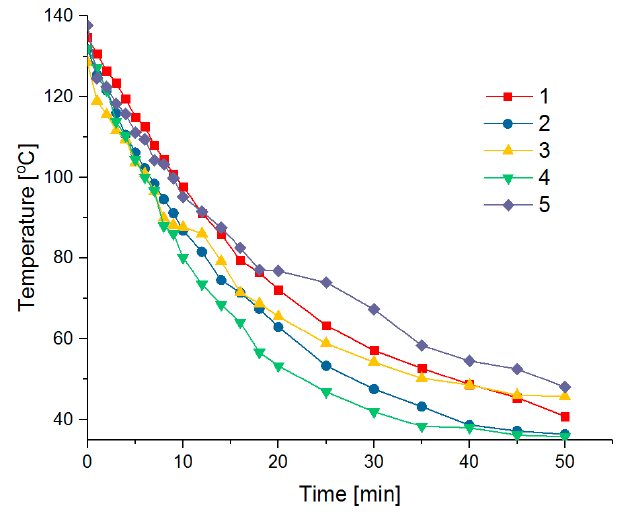
Figure 5. Combined temperature distribution diagram on the surface of cooling samples.